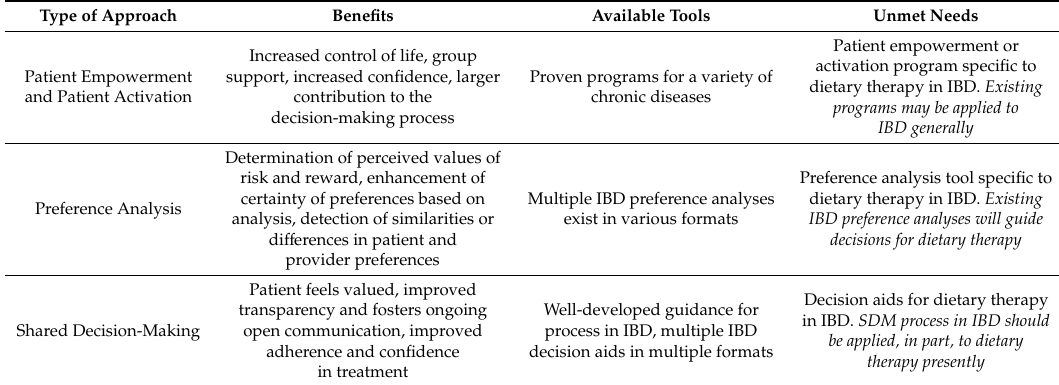
Table 2. Approaches to improve decisions about dietary therapy in